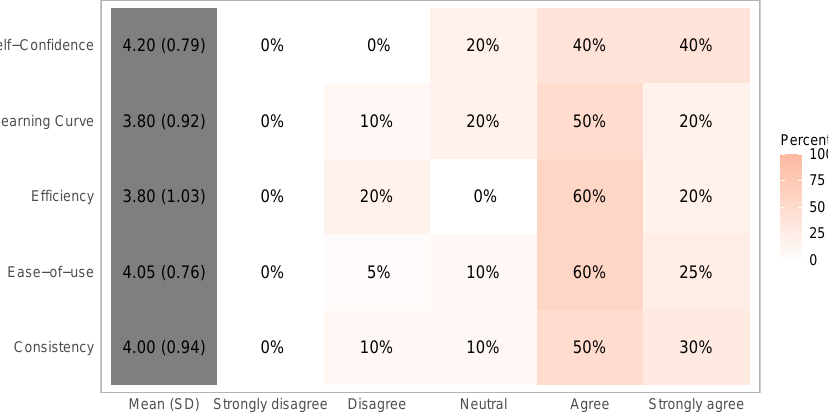
Figure 6. Results showing usability agreement by dimension for Use Case 1.